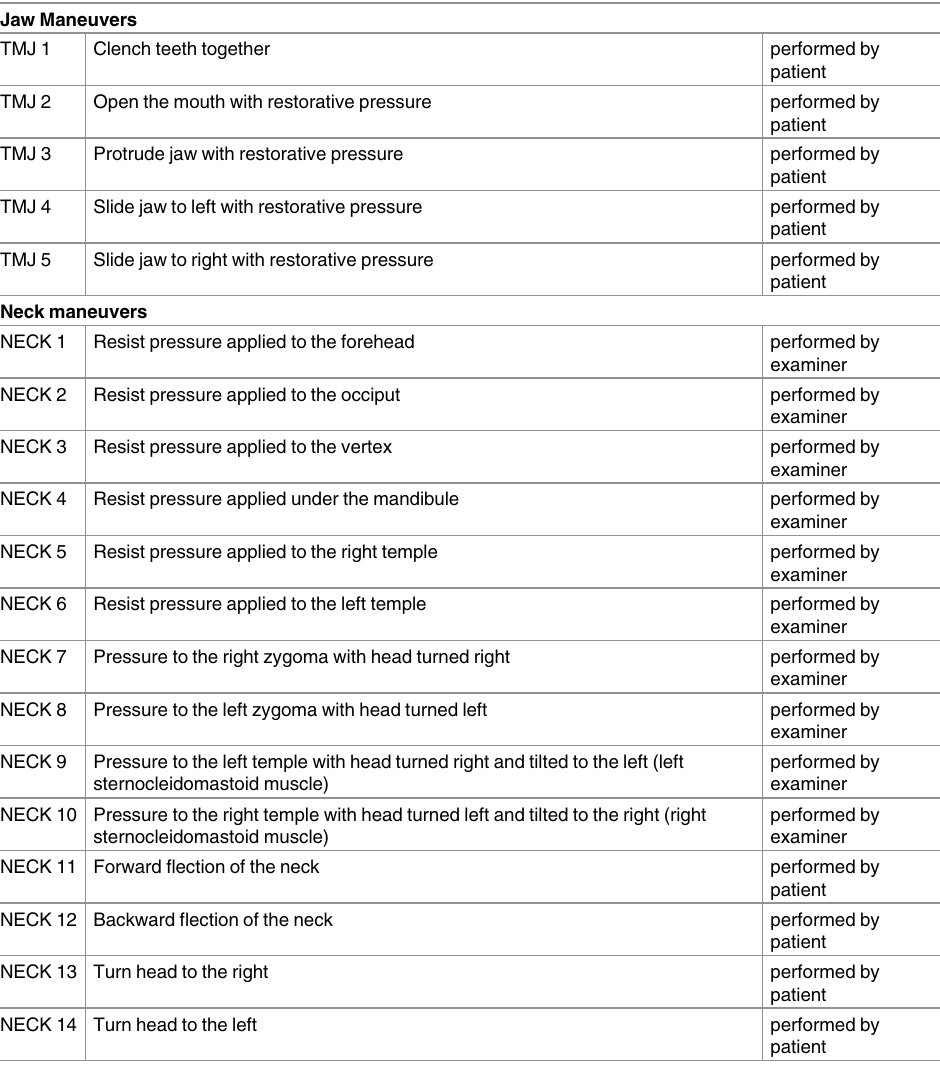
Table 1. Somatic